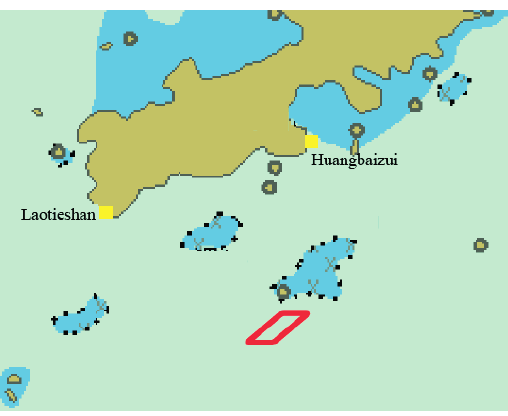
Figure 5. Distribution of AIS base stations and the vessel’s trajectory.